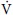
Association between the dead space and emphysema.The total LAA scores were positively correlated with the estimated dead space fractions (V˙
d/V˙
t) (p<0.001, r = 0.416).